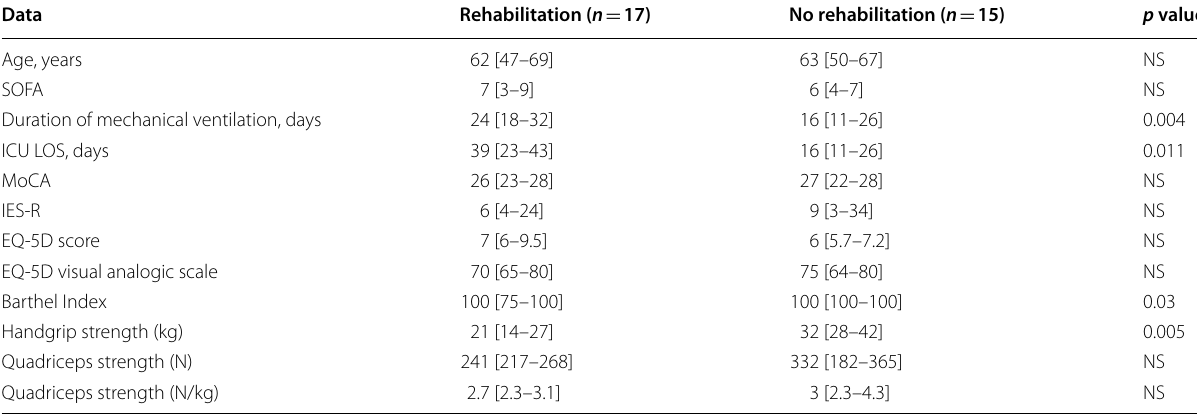
BMI body mass index, ICU intensive care unit, LOS length of stay, SOFA sequential organ failure assessment